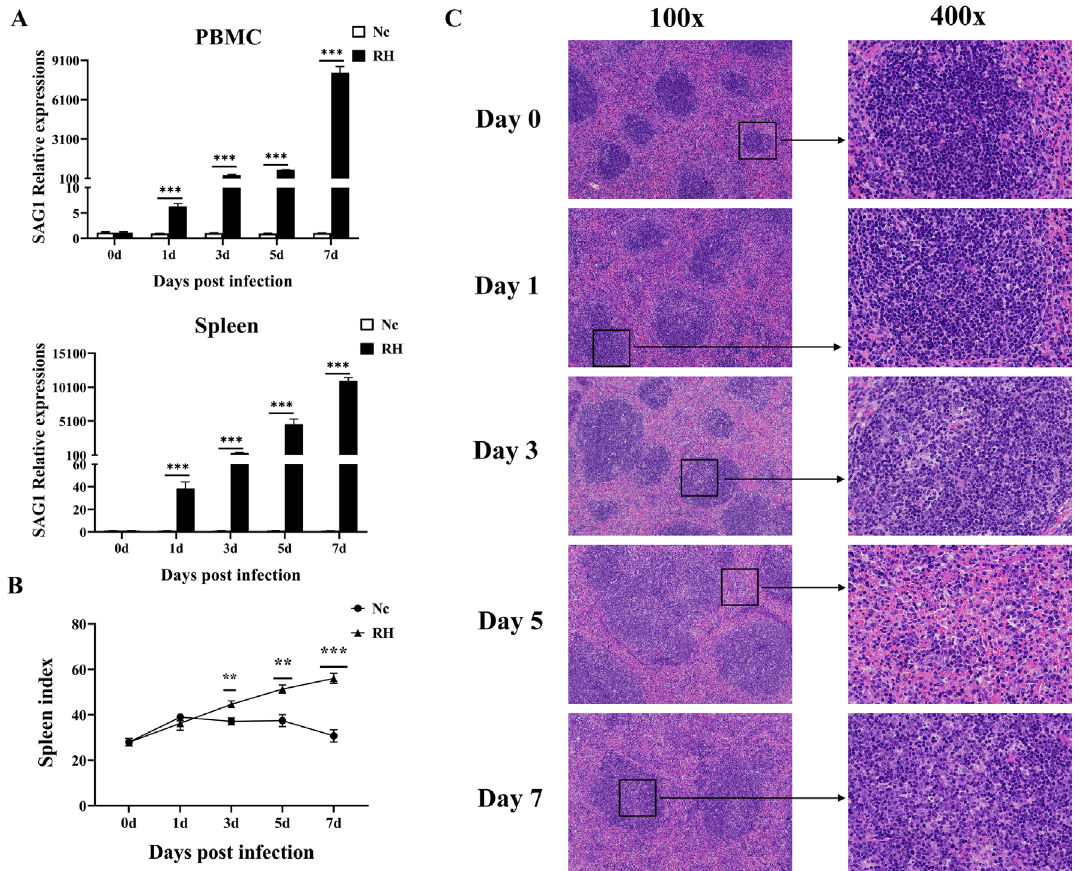
Figure 4. Dynamic pathological changes in the spleen during acute T. gondii infection. (A) Relative expression of TgSAG1 at 0, 1, 3, 5, and 7 days post infection in the PBMCs and spleen. (B) Spleen index values of the RH and Nc groups. The results are representative of three independent experiments with fi ve mice per group per experiment; with data denoting means ± SDs; (C) H&E staining of spleen sections at different time points in the RH infection group. The original magni fi cation was 100 (cid:3) , and the corresponding images on the right were magni fi ed at 400 (cid:3)